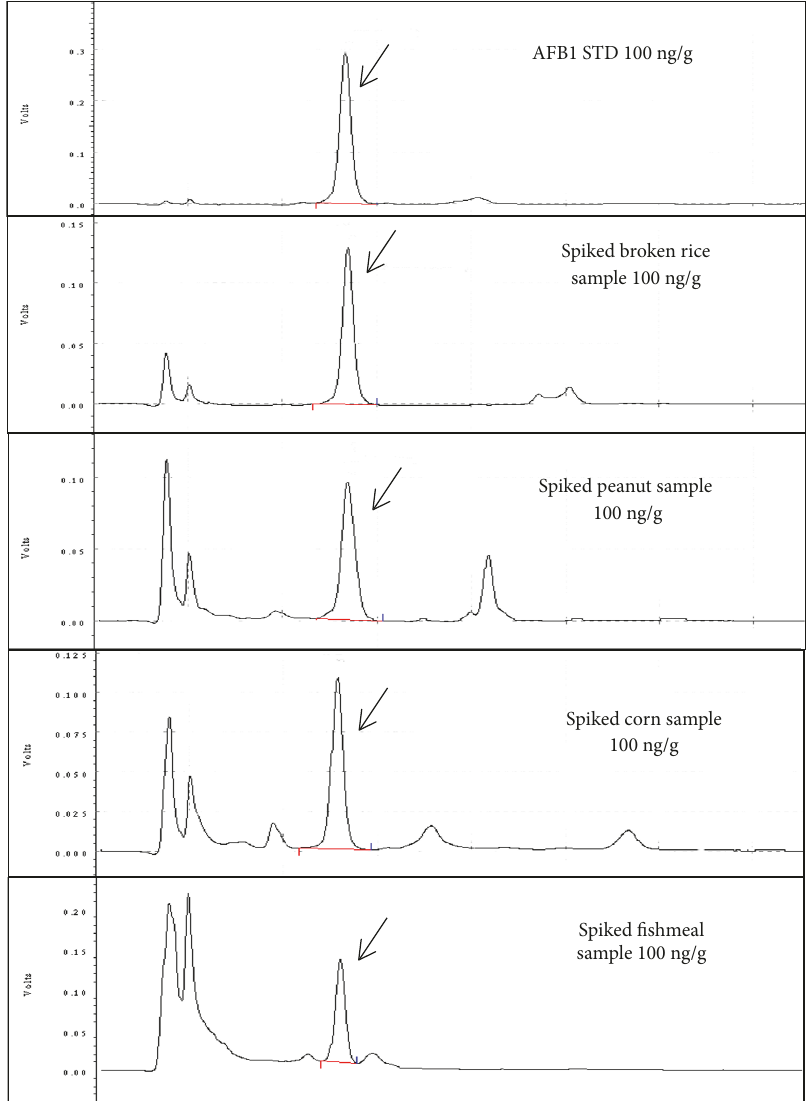
Figure 1: Chromatograms of AFB 1 standard solution containing 100ng/g and sample matrices (broken rice, peanut, corn, and fishmeal) were spiked with AFB 1 standard solution at